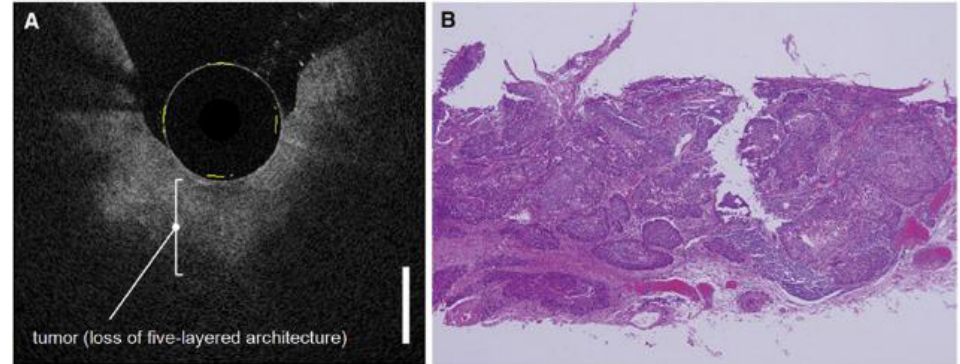
Figure 5. Example of endoscopic OCT of an esophageal squamous cell carcinoma. Corresponding OCT ( A ) and histology ( B ) image of tumor invasion in the submucosal layer, resulting in a loss of the five layered architecture (Bar = 1000 μm). Reprinted with permission from [74]. Copyright 2010 Elsevier: Gastrointestinal